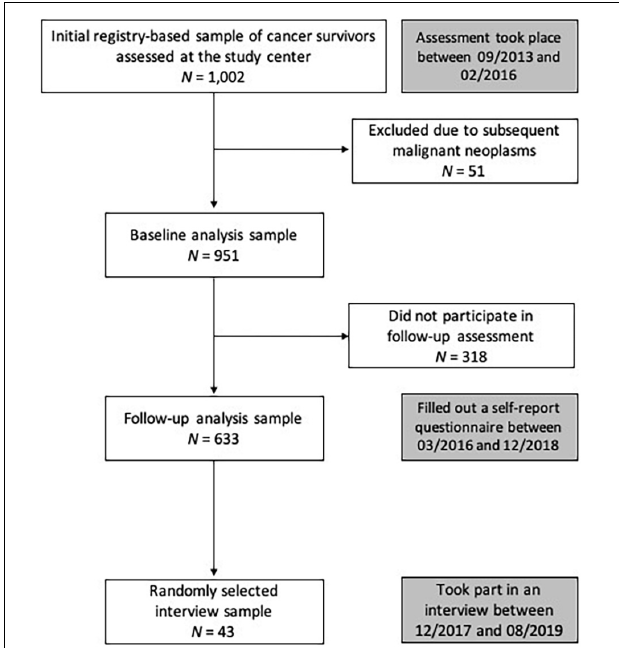
FIGURE 1 | Participant flow and timeline. Between 2013/09 and 2016/02, 1,002 CCS were examined at the study center. After excluding 51 individuals due to subsequent malignant neoplasms, the baseline sample comprised 951 CCS. The current study analyzed the data collected via self-report questionnaire, which was sent to participants more than 2 years later (follow-up assessment) and completed by 633 individuals. These follow-up data constitute the core data base of the present study. We selected a subsample of 43 participants for in-depth interviews (following pre-specified categories to represent the heterogeneity of the sample, e.g., gender, cancer diagnosis, current health, participation in medical follow-up). Within these categories, interview participants were drawn